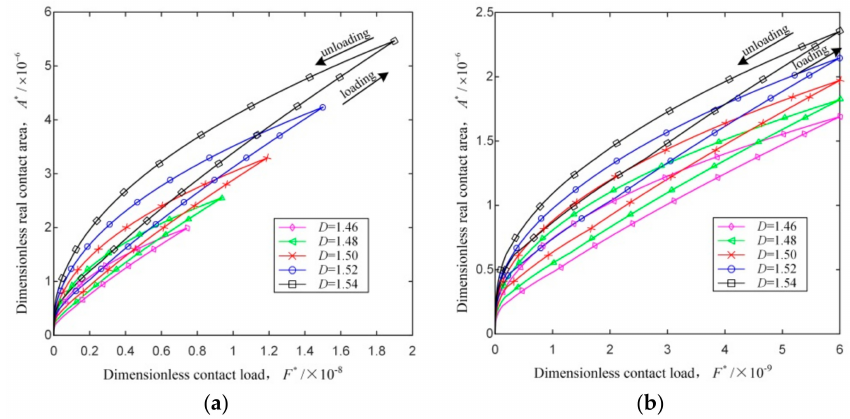
Figure 3. The relation between dimensionless real contact area and dimensionless contact load of two cylindrical surfaces in the second elastoplastic stage with di ff erent fractal dimensions with G = 10 − 10 mm, R c1 = 100 mm and R c2 = 60 mm. ( a ) Unloading at the dimensionless critical contact load; ( b ) unloading at a given dimensionless contact